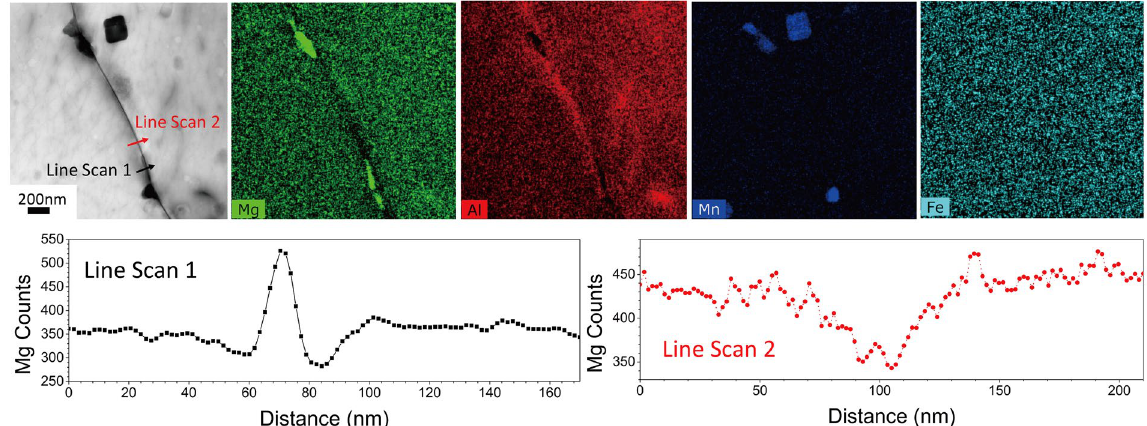
Figure 8. Scanning TEM image showing grain boundary decorated with β -phase precipitates in AA5083 sensitised at 100 °C for 30 days; along with the corresponding EDS map of Mg, Al, Mn and Fe. Line profiles are also presented for the variation in Mg for the lines denoted in the TEM image. Line Scan 1 shows the increase in Mg content across a β -phase precipitate, whilst Line Scan 2 reveals the Mg depletion across the grain boundary in a region with no β -phase precipitates.